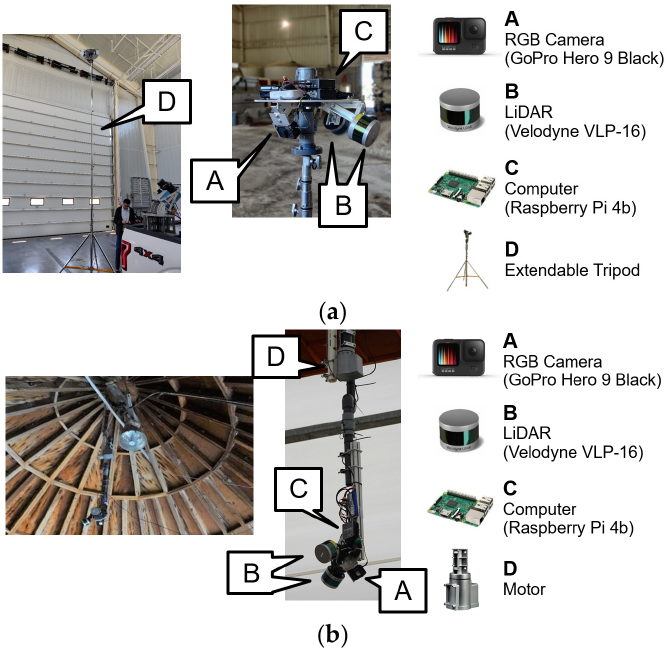
Figure 2. The integrated SMART system used in this study with two configurations: ( a ) tripod- mounted and ( b ) roof-mounted.